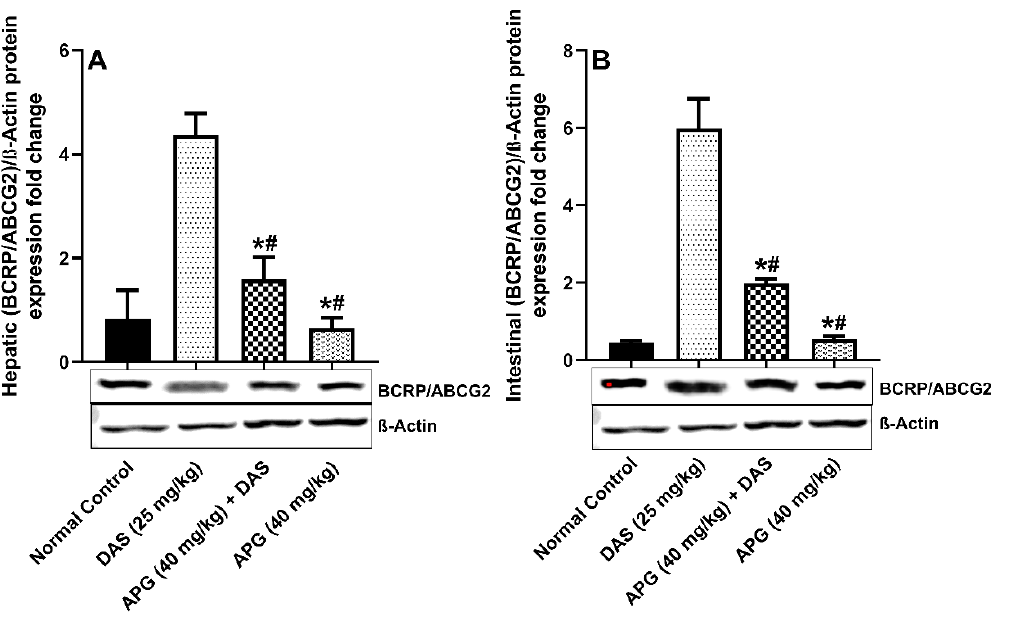
Figure 5. Hepatic ( A ) and intestinal ( B ) BCRP/ABCG2 protein expression in rats after DAS administration with or without APG pretreatment. All results are presented as the average ± SD. * p < 0.05 (Normal control); # p < 0.05 (DAS).